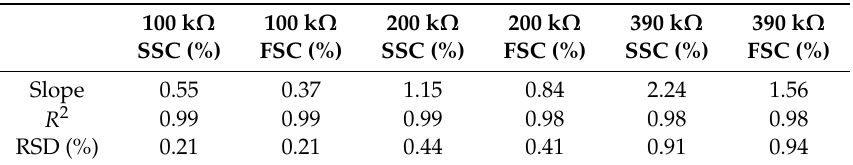
Table 3. Summary of the measured SSCs and RSCs of R6G labeled HeLa cells using load resistors at different concentrations with #74 excitation filter (480 nm) and #389 emission filter (500 nm), n = 12/cell numbers.